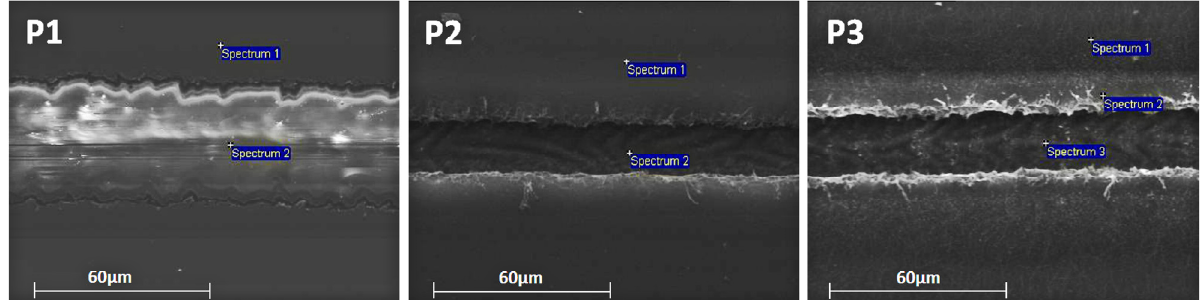
Figure 6. SEM images for the optimum laser parameters (blue marks indicate the EDX analysis spots). Table 2. EDX analysis at the blue marked spots in Figure 5.